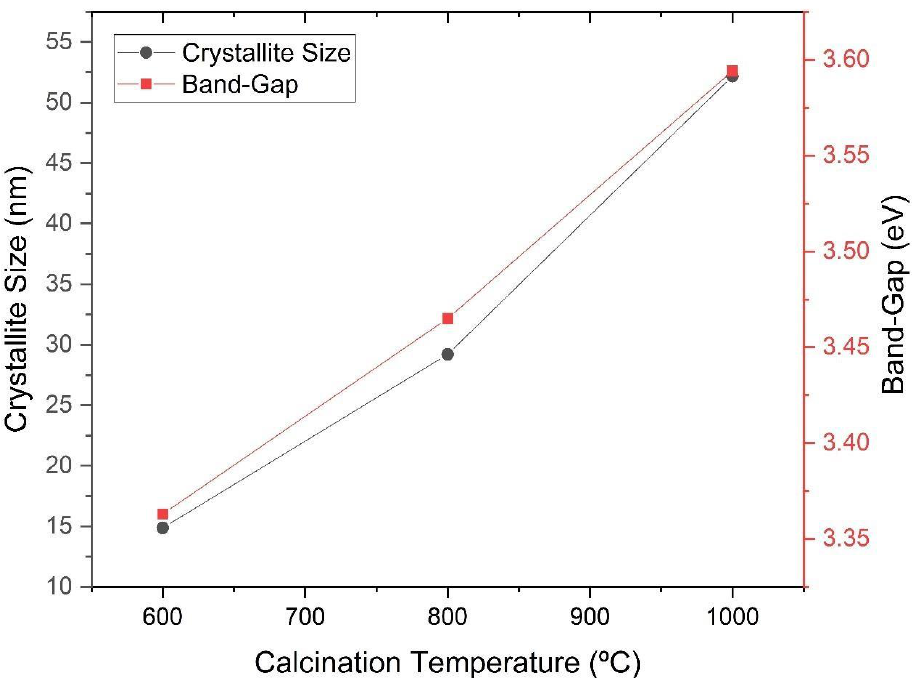
Figure 11. Band gap according to the size of the crystallites of the powders obtained by the sol-gel method and heat-treated at different temperatures (600 °C, 800 °C and 1000 °C).